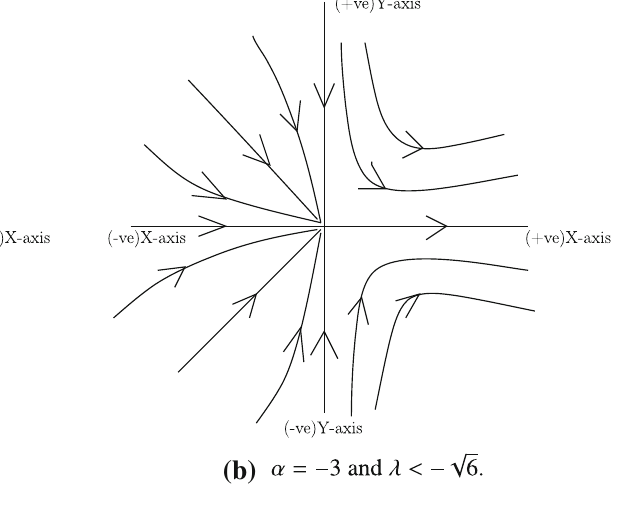
Fig. 1 Vector field near P 1 for α = − 3 and λ (cid:6)= undetermined when α = − 3 and λ = the eigenvalues of Jacobian matrix are